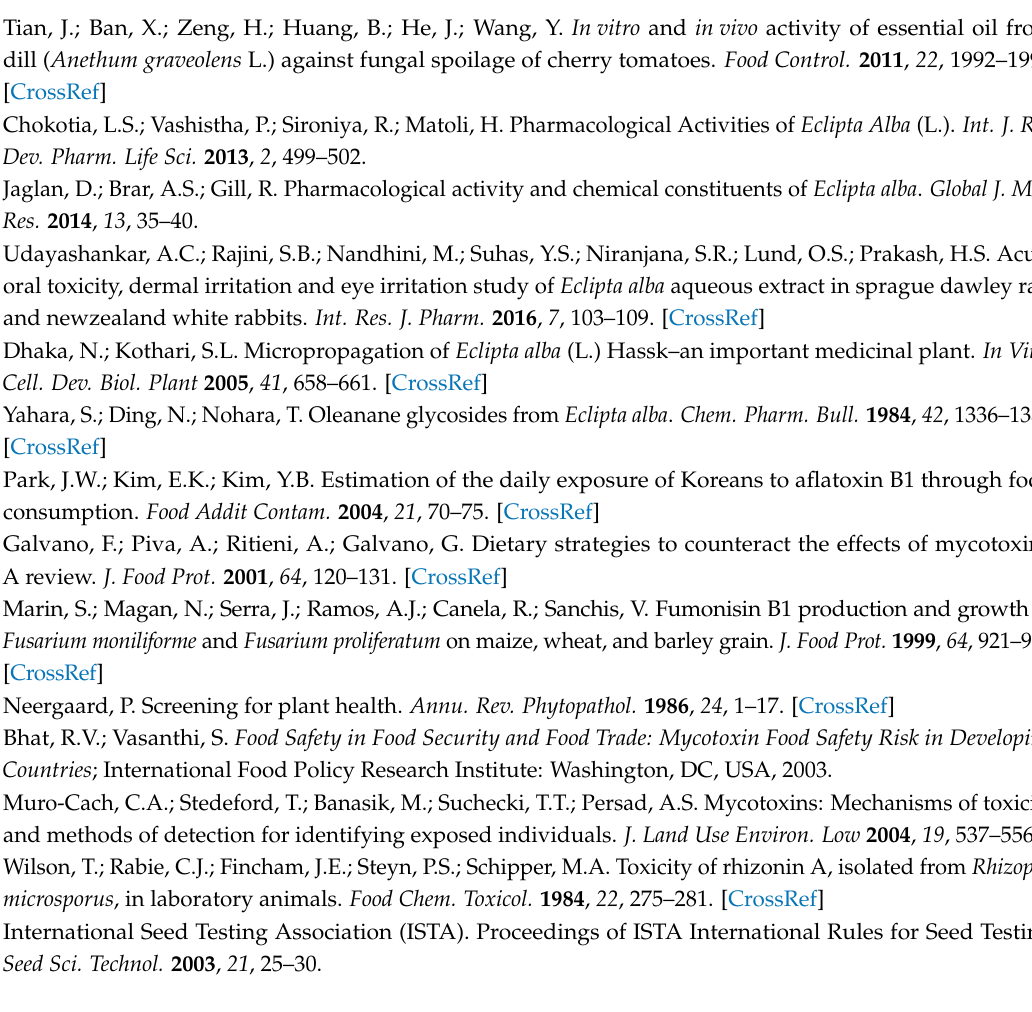
Figure S1: Effect of seed treatment with E. alba extract (120mg/mL) on emergence of seedlings for seeds infected with (A) Pathogen control ( F. thapsinum ) (B) Water treated control (C) Bavistin treated (D) F. thapsinum (E) E. sorghinum (F) A. alternata (G) C. lunata , Figure S2: (A) Effect of seed treatment on performance of sorghum in field trials by randomized block design (30 DAS), (B) Effect of seed treatment on performance of sorghum in field trials by randomized block design (60 DAS), Figure S3: UPLC MS/MS full scan m/z 100 -1700 spectra of E. alba column purified sample, Figure S4: Mass chromatography data of (A) Apigenin, (B) Wedelolactone, (C) Eclalbasaponin II, and (D) EclalbasaponinVI, Table S1: Major peaks retention time and peak area of column purified fraction of E. alba at 260